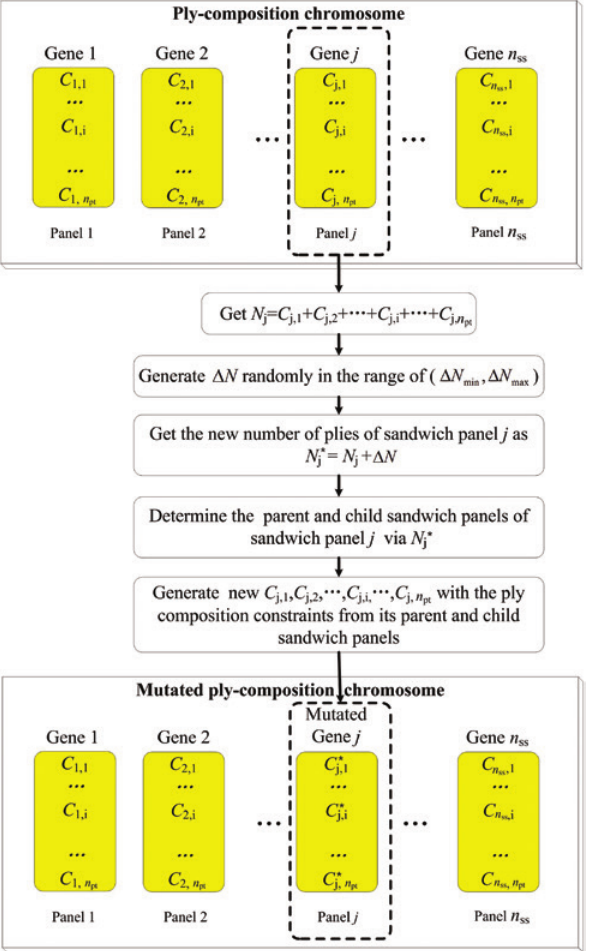
Figure 8: Mutation of a ply-composition chromosome.